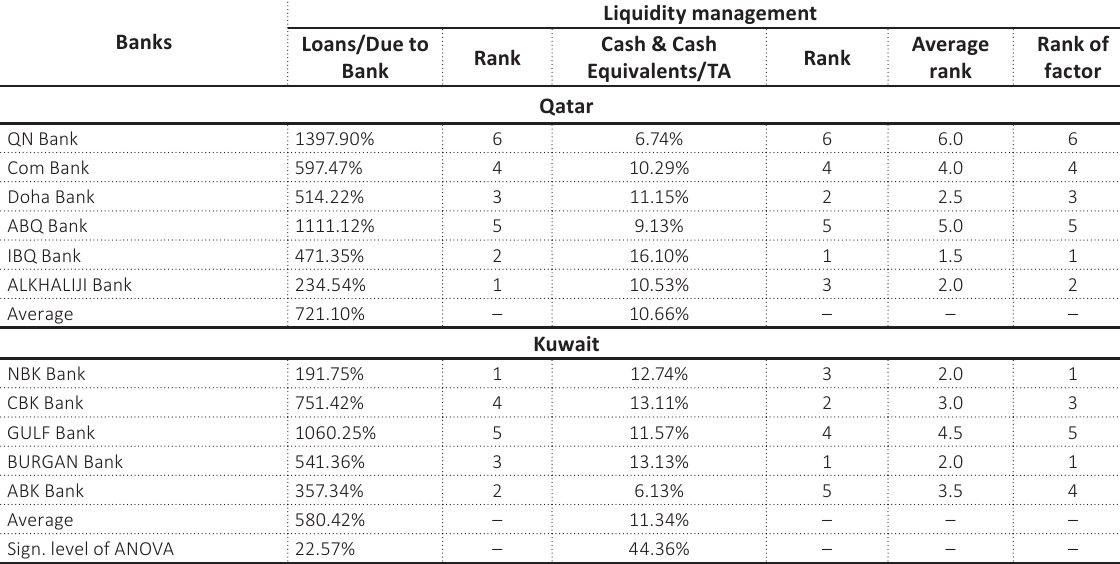
Table 7. Average ratios of years and rankings in the case of the Liquidity management factor at selected banks